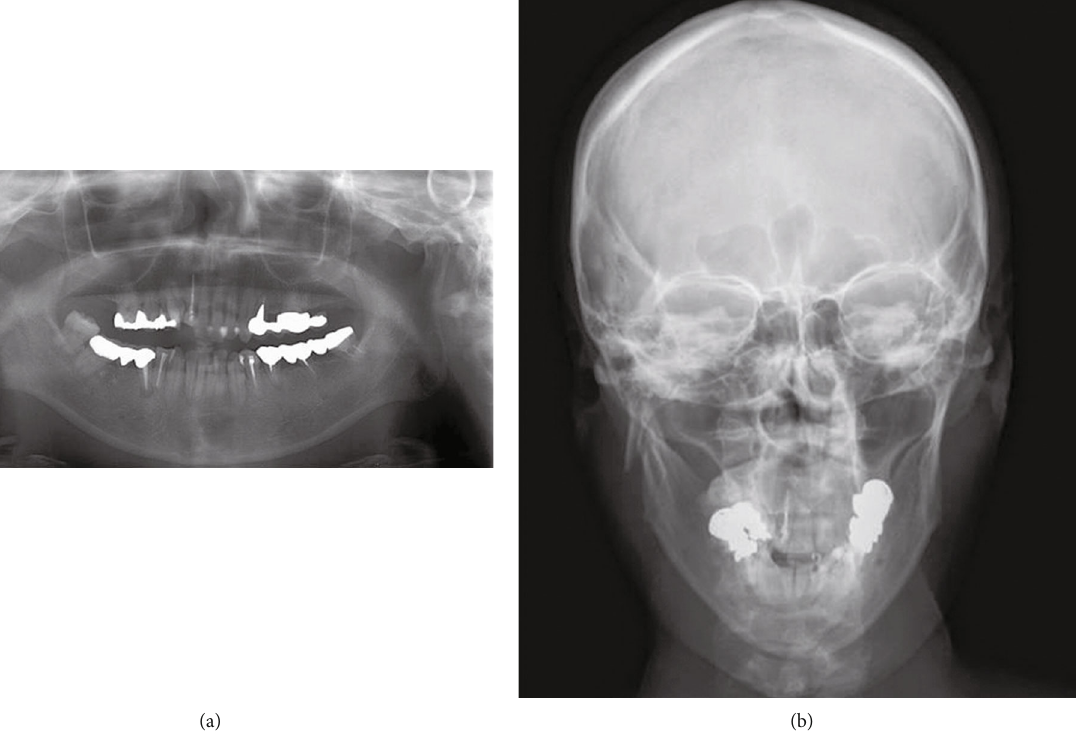
Figure 1: (a) Panoramic X-ray at the fi rst visit. A right mandibular condylar base fracture is observed. (b) A simple head X-ray at the fi rst visit (P-A). A fracture of the right mandibular condyle and external displacement of the bone fragment are